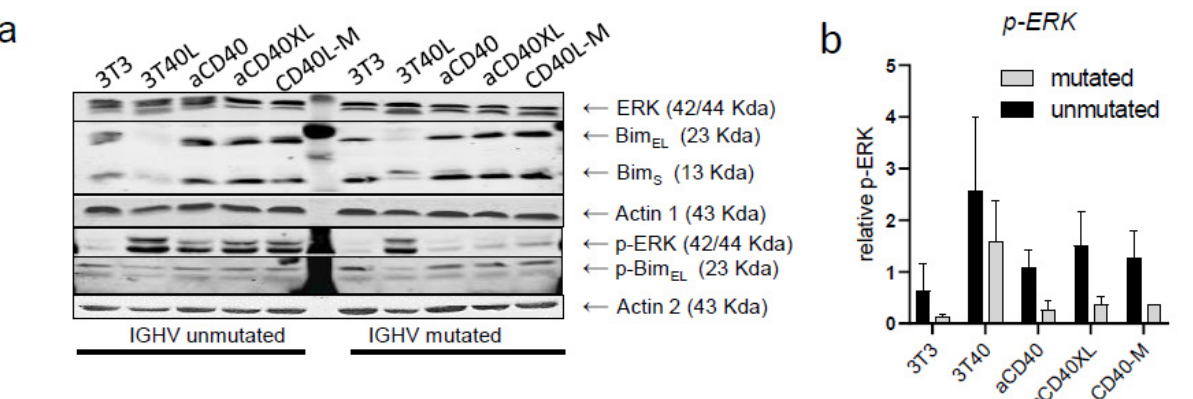
Figure 4. Differences in BIM -EL between IgHV-mutated and unmutated patients due to changes in ERK phosphorylation. ( a ) Changes in expression of BIM and ERK signaling were monitored by Western blot after 48 h stimulation. Results from a representative CLL sample of 4 patients. Equal protein loading was confirmed by staining for actin. ( b ) Protein quantification (IgHV unmutated N = 2; IgHV mutated N = 2) measured by ImageJ as a ratio of each protein band relative to the lane’s loading control (mean ± SEM).